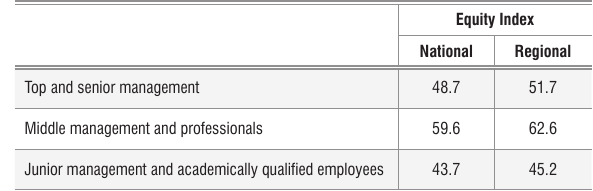
Equity Index National Regional